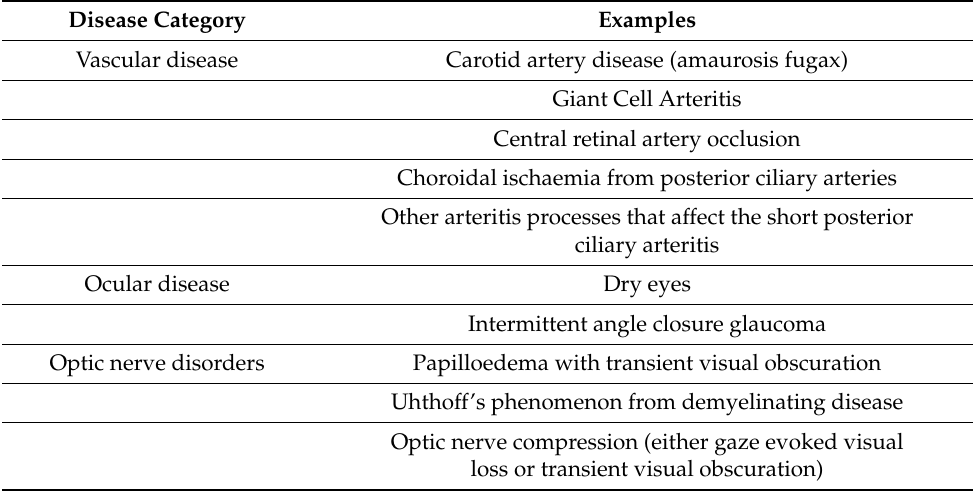
Table 1. Examples of differential diagnosis of